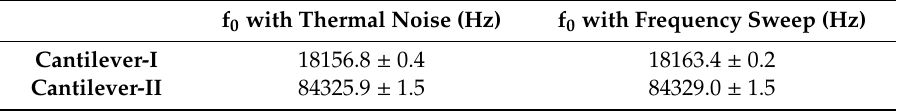
Table 1. The measurement of the resonance frequency of two di ff erent types of micro-cantilevers with thermal noise density and frequency sweep experiments. For both cantilevers, the resonance frequency increases with the oscillation amplitude. Experimental data are the average of 5 independent measurements of 50 spectra averaged together. The resonance frequency is determined by fitting a Lorentzian function to the thermal noise spectrum. The oscillation amplitude at the resonance frequency is 8.2 nm for cantilever-I and 7.5 nm for cantilever-II. The experimental setup was kept in a quiet room during the experiments to eliminate the e ff ect of acoustic noise